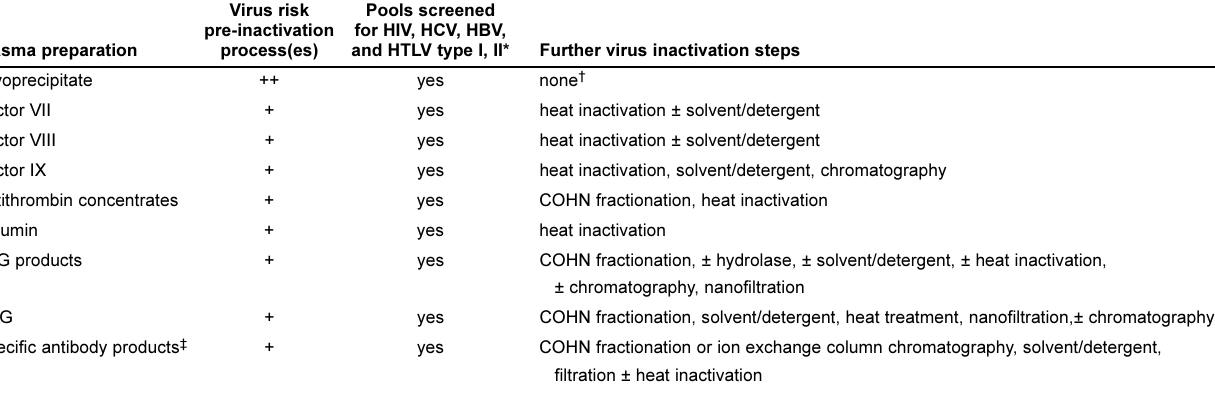
TABLE 3 Manufacturing steps to decrease infectious risks of plasma preparations and plasma-derived components Virus risk Pools screened pre-inactivation for HIV, HCV, HBV,